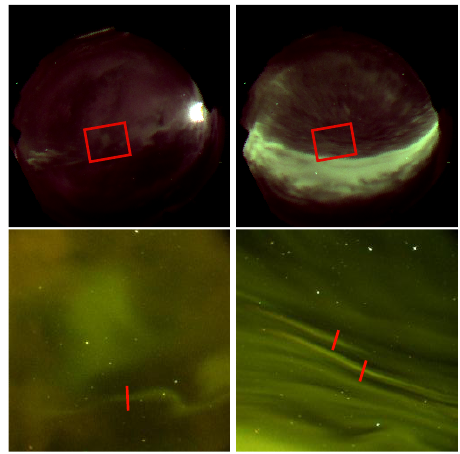
Fig. 5. Two examples of the DAISY images (lower panel) from the unit with the narrowest FoV. The images in the top panel are from an all-sky camera at AUGO. The red squares in the top panel images denote the approximate FoV of the DAISY images. Thin auroral structures can be seen in found in both images. Exposure time of 4s was used to capture these at 05:49:36 (left column) and 08:18:48UT (right column) on 24 March 2007. The thin structure in the image on the left hand side is a folded one, and the aurora (green) is partly behind some thin clouds (orange). In the image on the right, two almost straight arc-like structures are seen as brighter lines across the FoV. The widths measured from these images are 1.2km (left), and 1.0 and 1.4km (right) along the red lines across the structures. North it to the top and east to the right in these